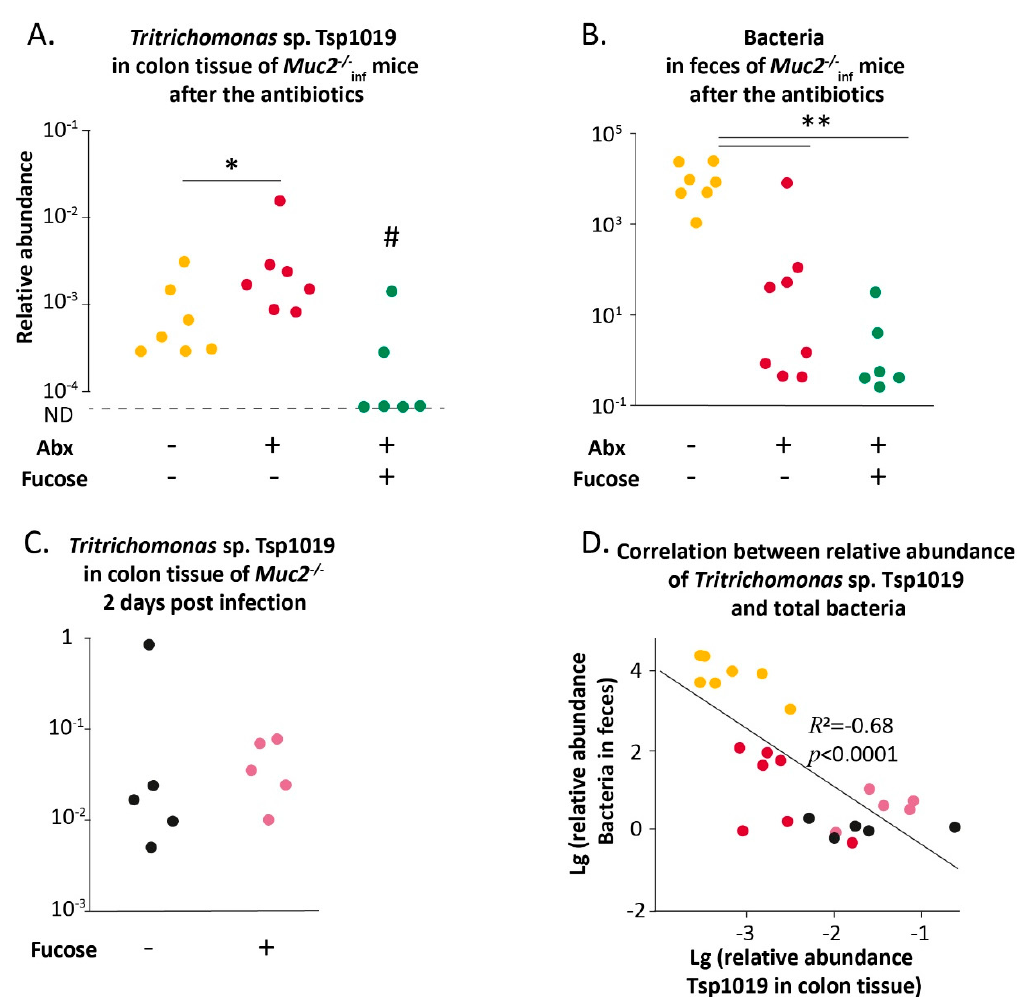
Figure 6. L-fucose prevents an expansion of Tritrichomonas sp. in colon of Muc2 − / − mice upon antibiotic-induced microbiota depletion. ( A ) Relative abundance of Tritrichomonas sp. in colon tissue of Muc2 − / − mice after treatment with antibiotics and antibiotics supplemented with L-fucose, normalized on Mus musculus 28S rRNA DNA. *—differences between groups p < 0.05, Mann–Whitney u-test. #— p < 0.05, Fisher Exact test. ND—not detected. ( B ) Relative abundance of the gut bacteria in feces of Muc2 − / − mice after treatment with antibiotics and antibiotics supplemented with L-fucose normalized on Mus musculus 28S rRNA gene. **—differences between groups p < 0.01, Mann–Whitney u-test. ( C ) Relative abundance of Tritrichomonas sp. in colon tissue of Muc2 − / − mice after infection via gavage. ( D ) Spearman correlation between relative abundance of Tsp1019 in colon tissue and bacteria in feces.